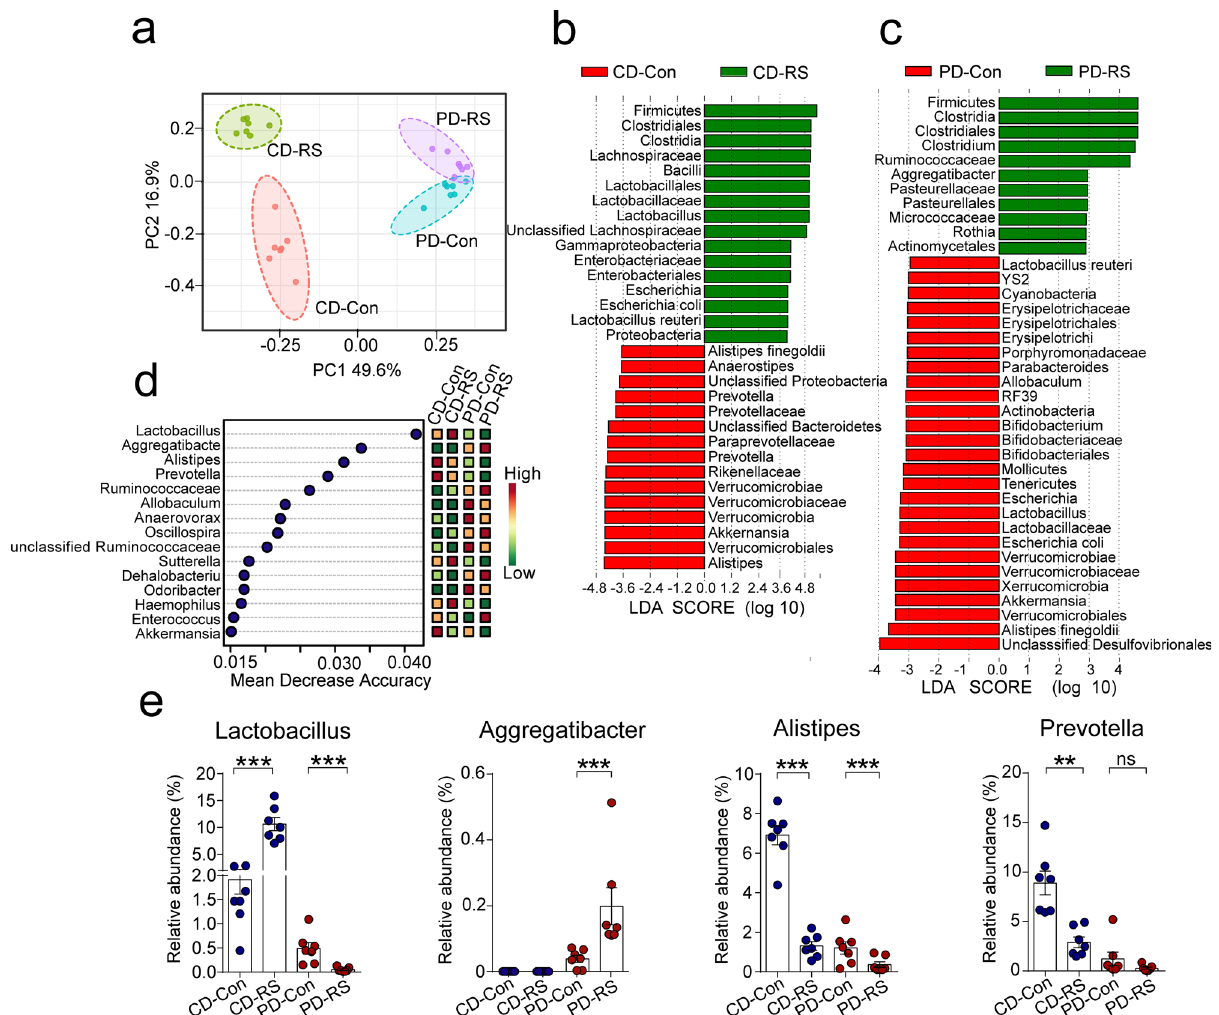
Fig. 2 Diet interplays with stress in remodeling the gut microbiota. a PCoA plot of bacterial Operational Taxonomic Unit (OTU) in fecal samples of mice fed with chow diet (CD) or puri fi ed diet (PD) at the end of 14-day restraint stress (RS). The community distance is based on Bray – Curtis dissimilarity metrics of relative abundance determined by 16s rRNA sequencing. Each symbol represents the data of an individual mouse ( n = 7). b , c Linear discriminative analysis (LDA) score of differentially expressed bacteria obtained from LEfSe analysis of fecal microbiota in mice fed with CD diet ( b ) or PD ( c ). A genus with Kruskal – Wallis ≤ 0.05, as well as LDA > 3.6 ( b ) or 3 ( c ) are shown. d The top 15 distinct bacterial genera identi fi ed by applying Random Forest Regression analysis of their relative abundances in control and stressed mice. e The relative abundance of Lactobacillus , Aggregatibacter , Alistipes , and Prevotella in the fecal microbiota of mice. Data are presented as mean ± SEM for n = 7. ** p < 0.01 and *** p < 0.001 by Wilcoxon rank-sum test. ns no signi fi